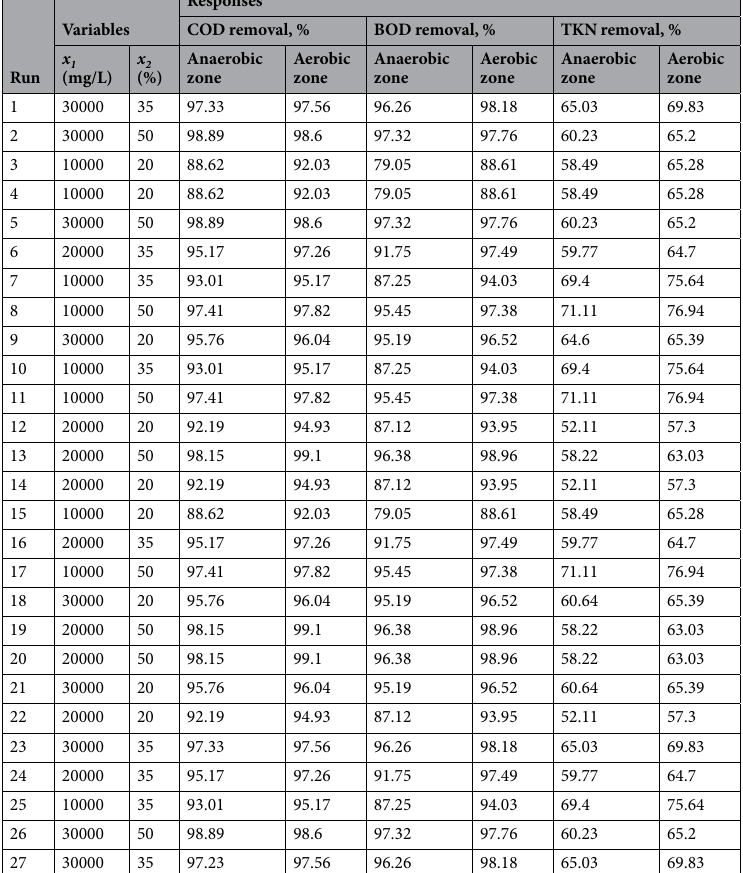
Table 5. Experimental conditions and results.